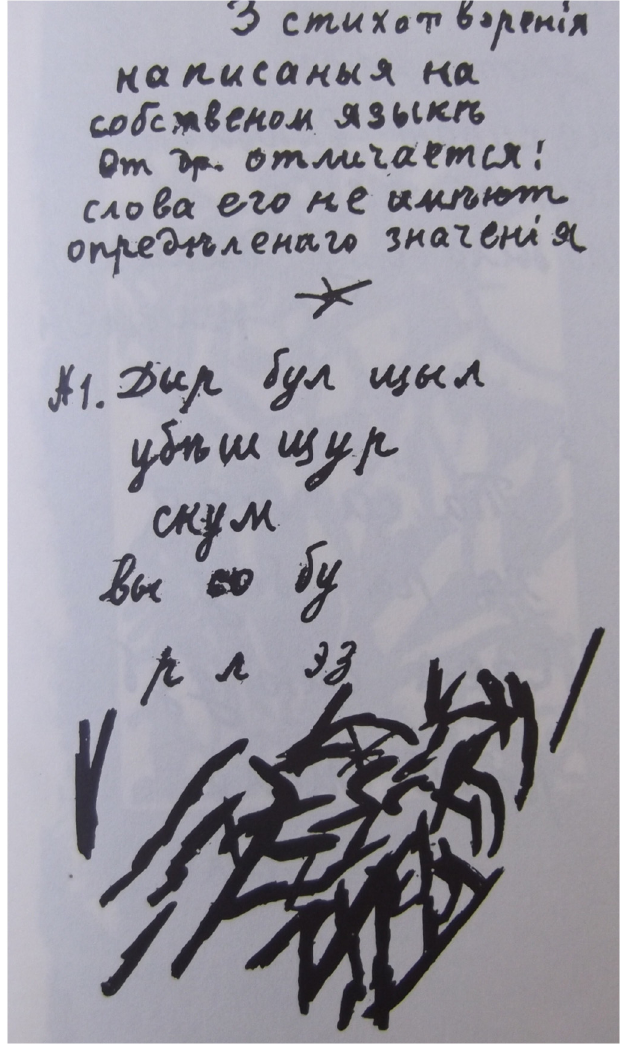
Figure 2. Kruchenykh’s ‘Dyr bul